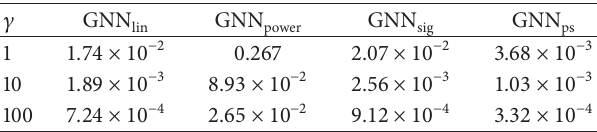
Figure 4: Online solution of QP problem (15) by GNN (14) with design parameter 𝛾 = 1 and the four basic activations. Table 1: Performance of GNN model by using different design parameter 𝛾 and